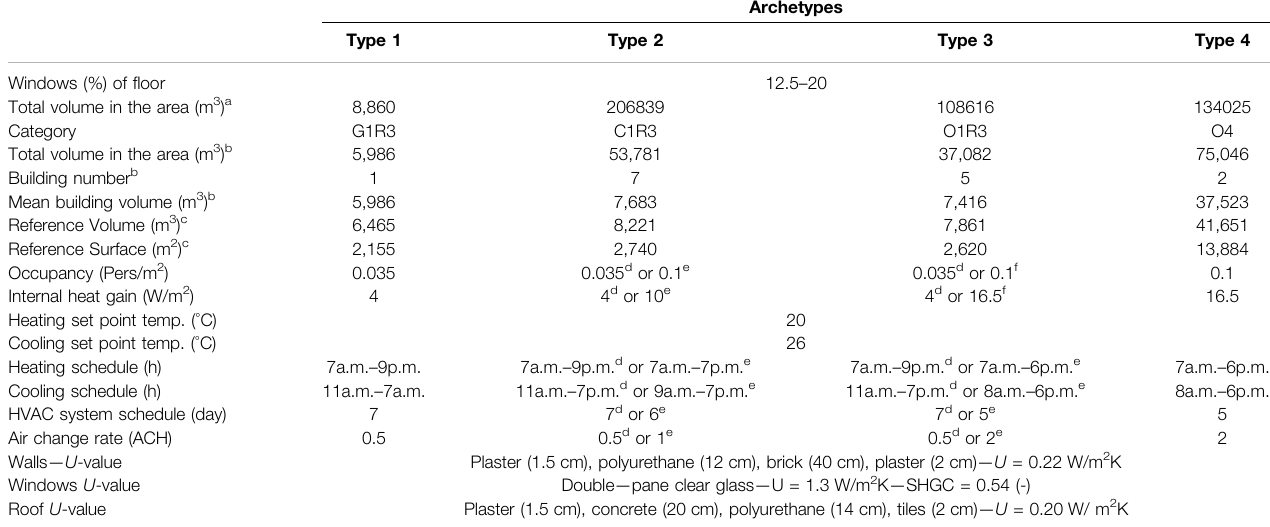
TABLE 2 | Characteristics and simulation parameters of the